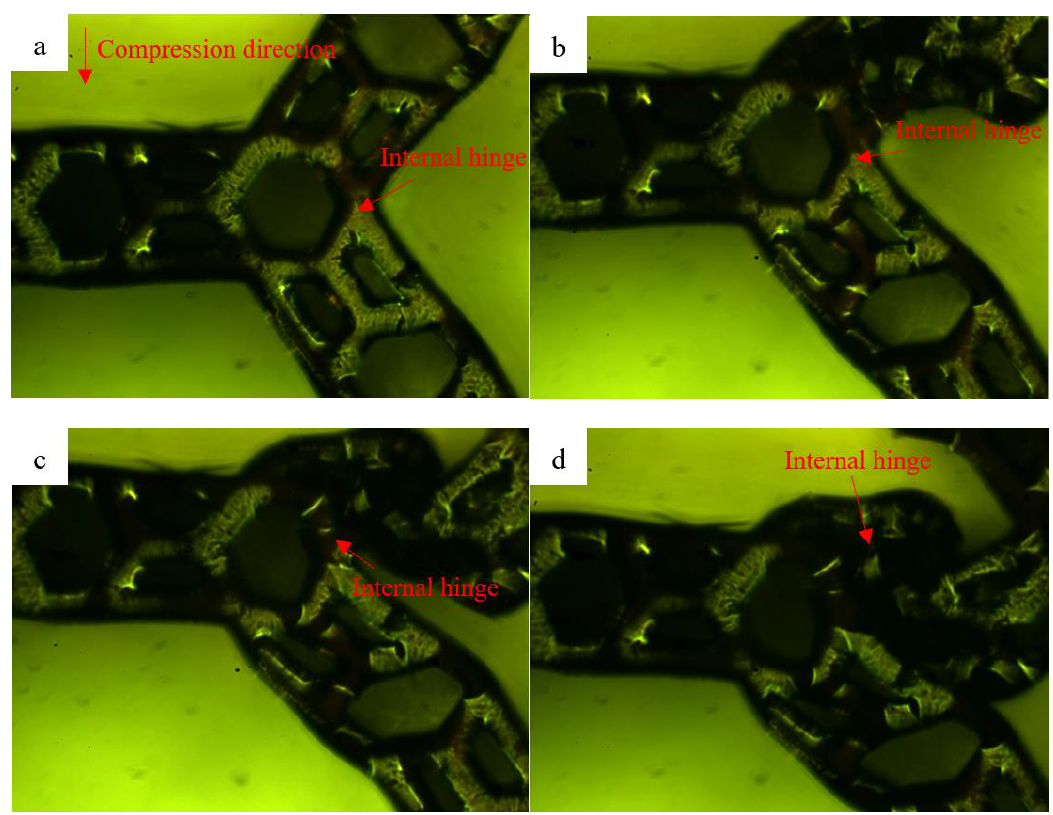
    = 0.08, ( b ) = 0.23, ( c ) = 0.36, ( d ) = 0.52. Figure 9. MHH material local hinge deformation process. ( a ) ε = 0.08, ( b ) ε = 0.23, ( c ) = 0.36, ( d ) ε =